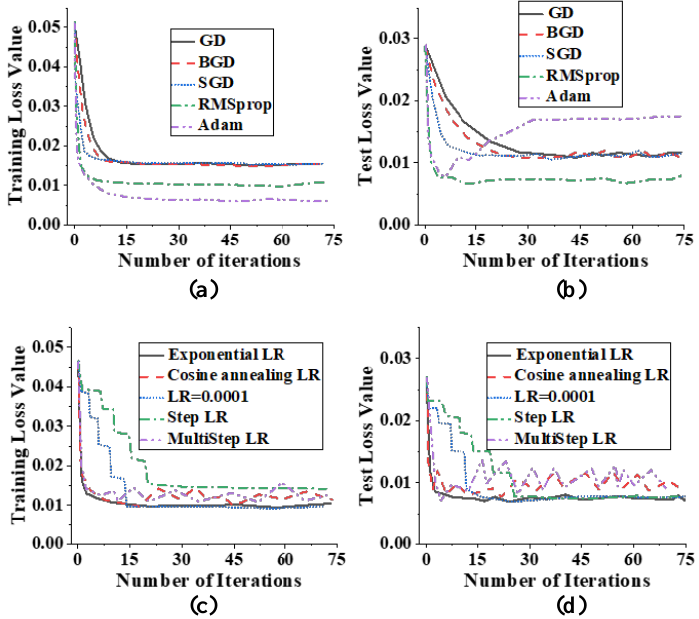
Figure 6. Contrast graph of training and test results under different overparameters. ( a ) Training losses with different optimizers; ( b ) test losses from using different optimizers; ( c ) training losses caused by iterative methods with different learning rates; ( d ) test loss with iterative methods of different learning rates.